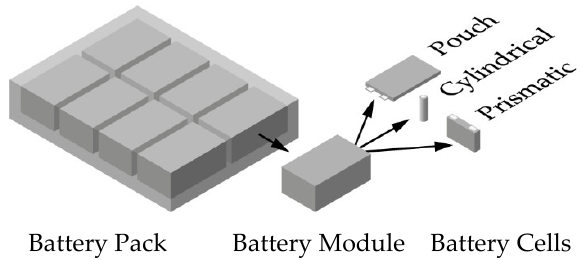
Figure 2. Number and share of electric vehicle sales in ( a ) Europe and ( b ) Norway, adapted from [25]. In EVs, the entire battery is often referred to as a battery pack. The battery pack typically consists of several battery modules which are comprised of individual battery cells in either a pouch, cylindrical, or prismatic cell format [26] (Figure 3).